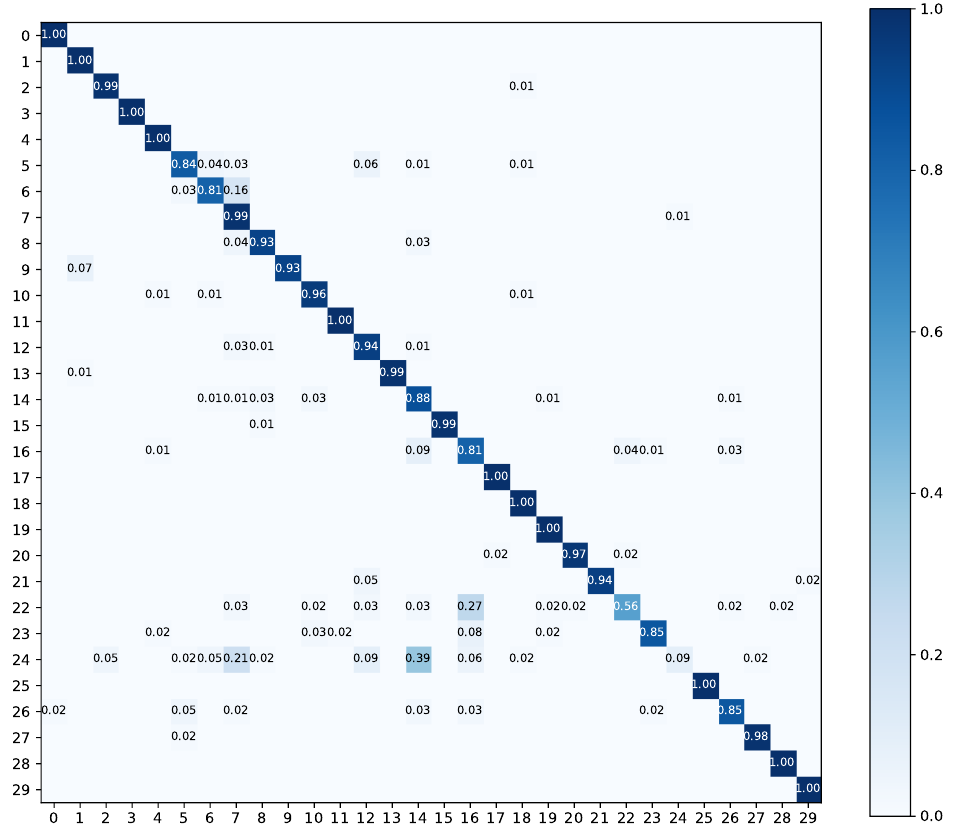
Figure 9. Confusion matrix obtained by our proposed method on AID testing set.